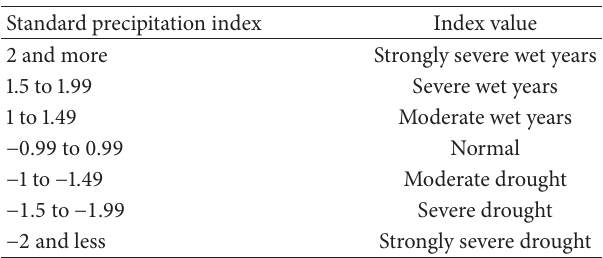
Figure 1: Geographical location of the researched area. Table 1: Varying intensities of drought based on standard precipita- tion